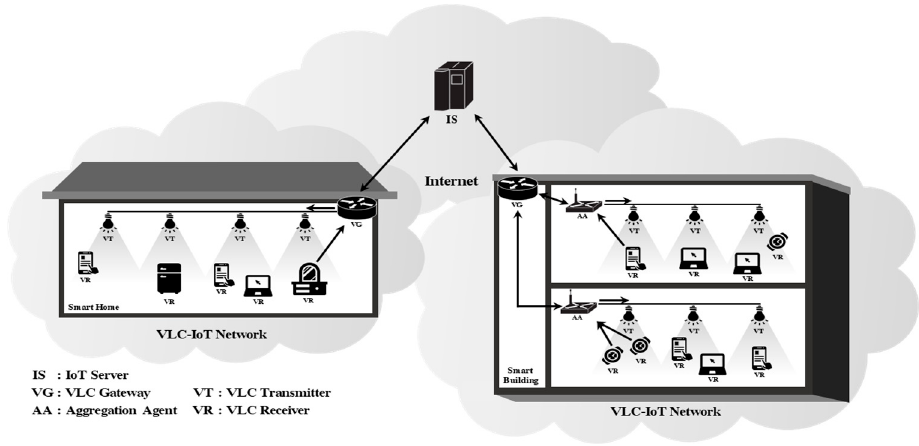
Figure 3. Framework of IoT services over unidirectional VLC networks.